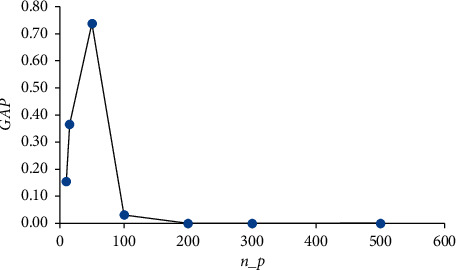
Variation of the GAPlu value according to np.